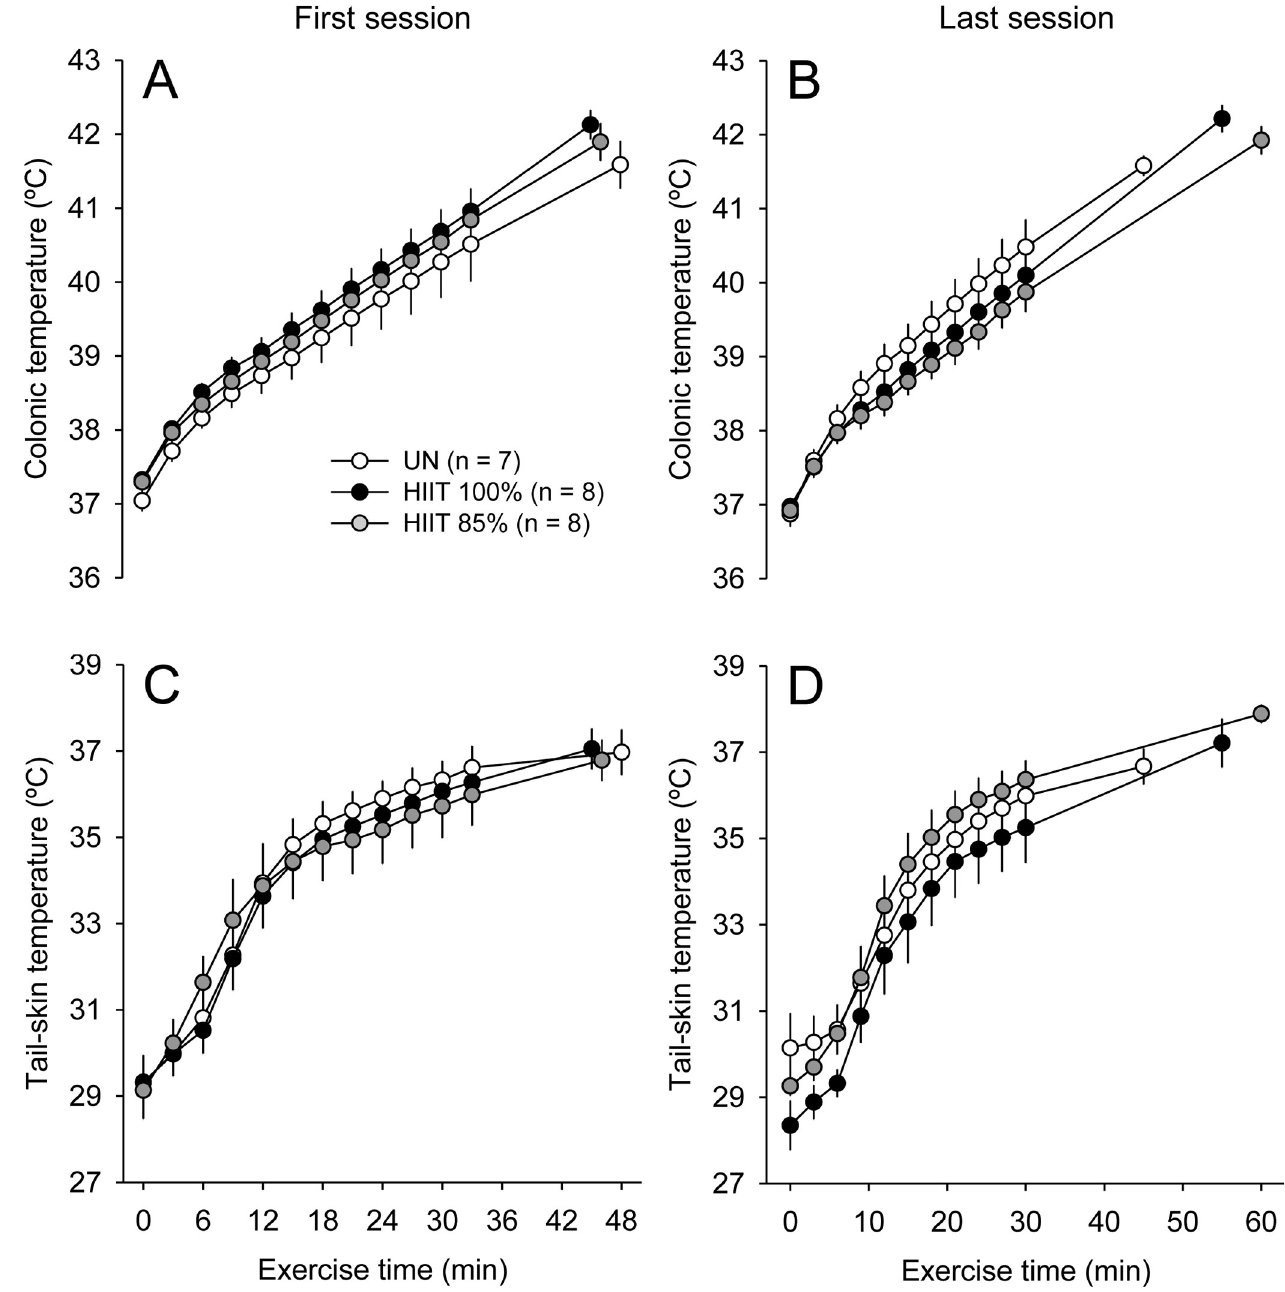
Fig 6. Colonic temperature (T COL ; panels A and B) and tail-skin temperature (T TAIL ; panels C and D) in rats of the three experimental groups during the incremental exercises at pre- (A and C) and post-interventions (B and D). The values are expressed as the means ± SEM. HIIT 100% : high-intensity interval training at 100% of maximal speed; HIIT 85% : high-intensity interval training at 85% of maximal speed; UN: untrained, passive heat exposure.